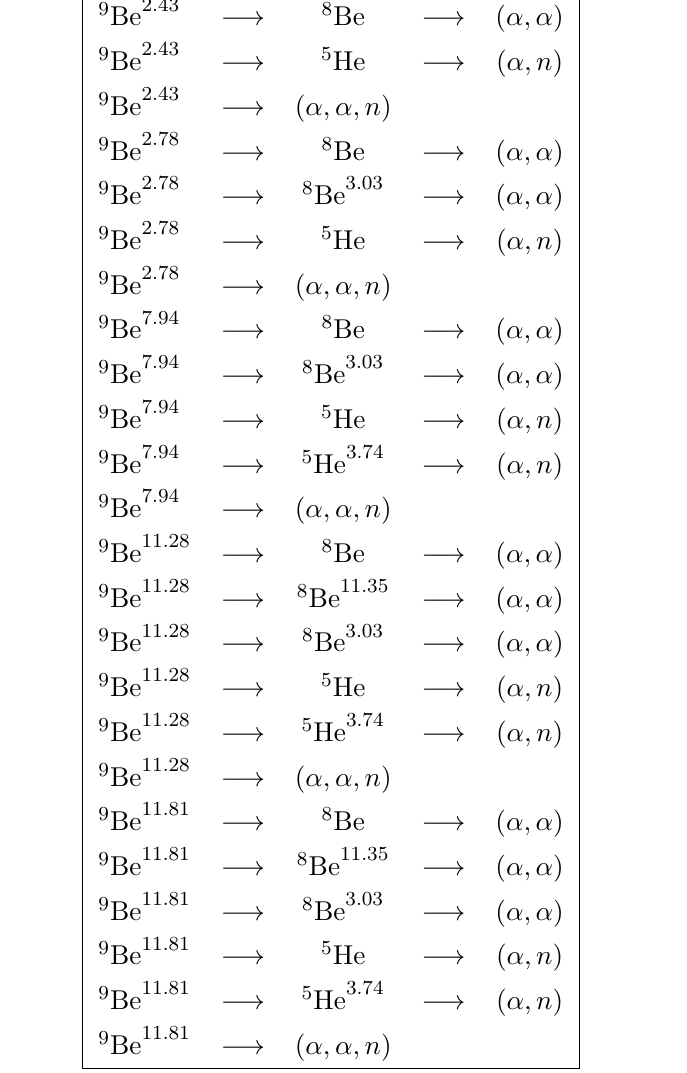
Table 3 . 9 Be decay paths relevant after the (cid:12) -decay of 9 Li. The energy levels (in MeV) relative to the ground state of 9 Be are indicated as superscripts of the chemical elements; when no superscript is present, the ground state of the considered nucleus must be